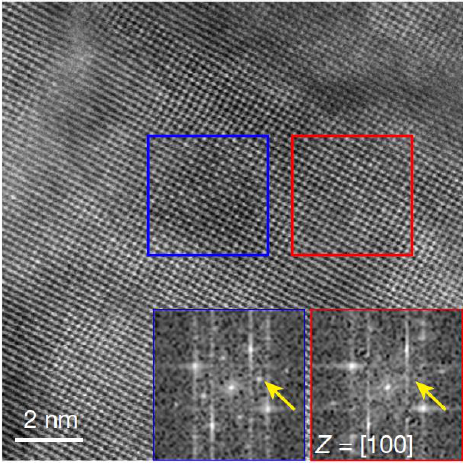
Figure 8. High resolution transmission electron microscopy (HR-TEM) image showing an ultra-fine B2 NiAl precipitate (blue box) maintaining a strong coherency with the surrounding Body Centered Cubic (BCC) Fe matrix (red box). The yellow arrow in the blue close-up view indicates the weak B2 NiAl superlattice selected area electron diffraction (SAED) diffraction spots. The supperlattice diffraction spots disappear and BCC diffraction spots are obtained in the red close-up view [3].